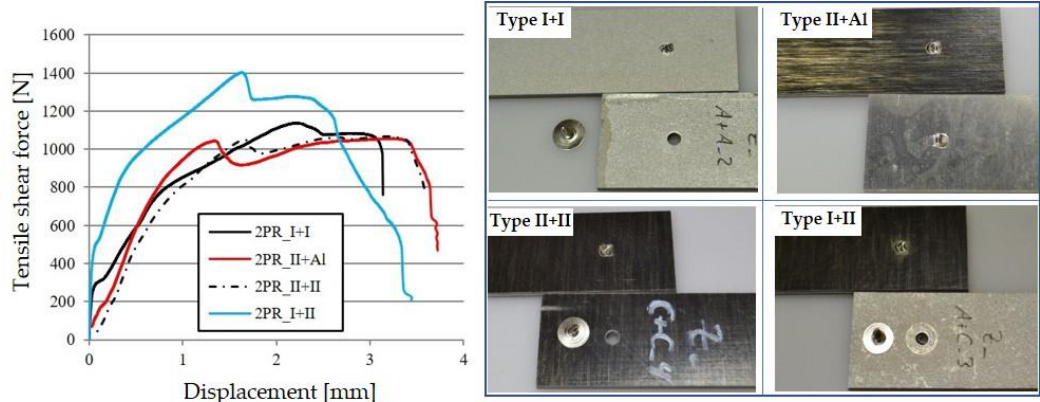
Figure 12. Tensile shear force and displacement curve with fractured joints after tensile shear test of two-part hollow rivet joining process.